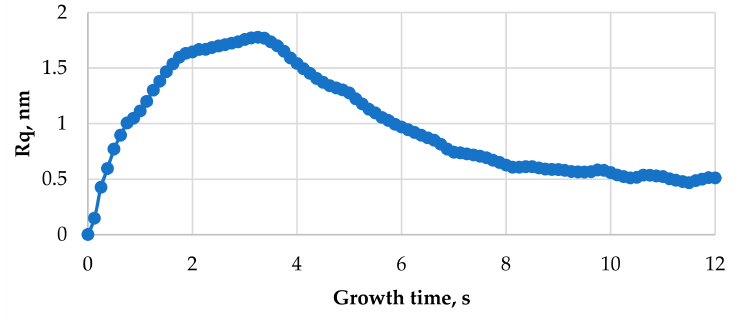
Figure 6. Plot of surface roughness vs. growth time at the substrate temperature of 773 K and the relative flux i = 1 s − 1